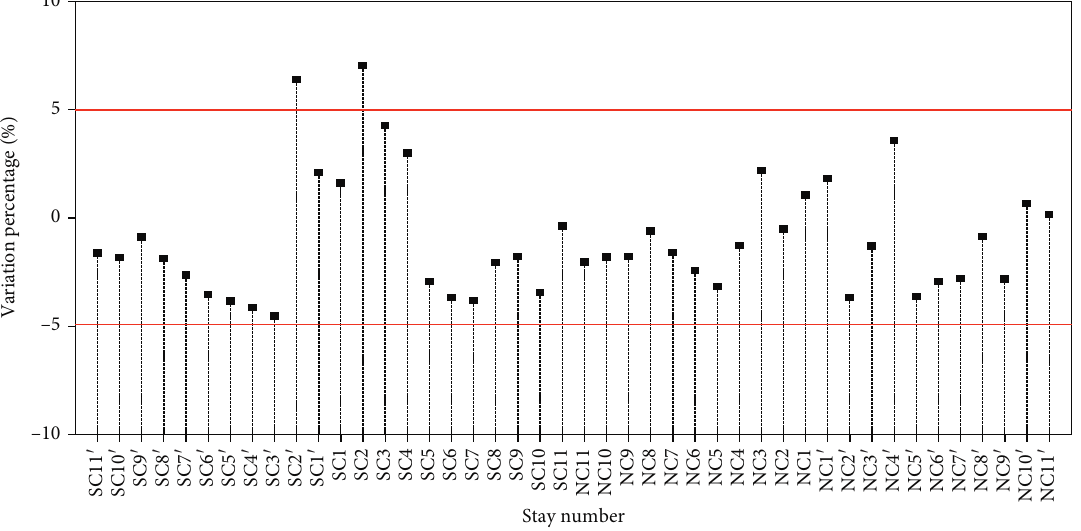
Figure 14: Variation in cable forces after adjustment relative to those before replacement.